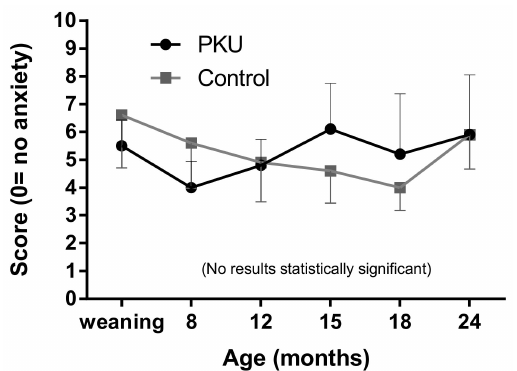
Figure 4. Mean anxiety scores for mothers of children with PKU and control